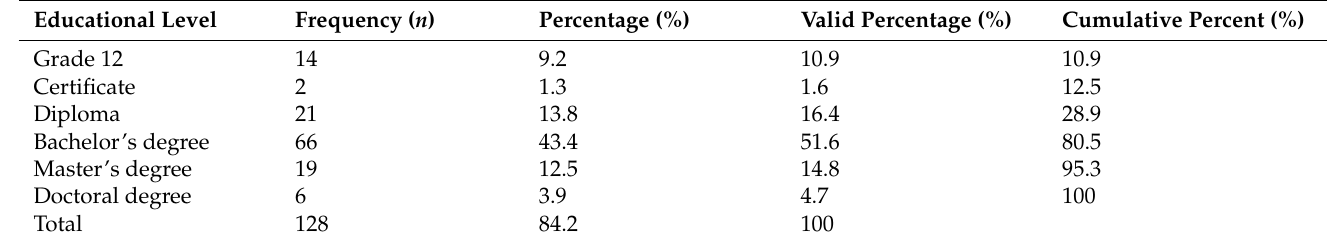
Table A1. Educational level.